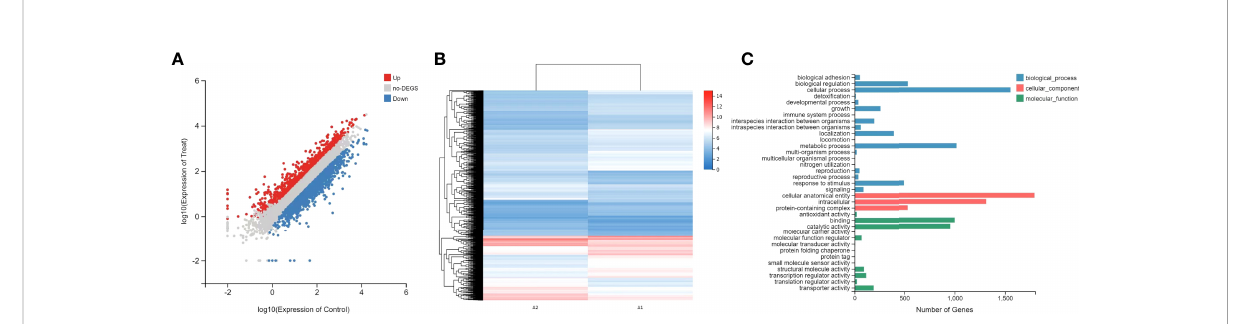
FIGURE 5 (A) Scatter plot of RNA-seq expression analysis. Upregulated genes are marked in red, and downregulated genes are marked in blue. (B) Heat map of RNA-seq expression analysis. Genes with statically signi fi cant changes were utilized to construct the heat map. The red color indicates relatively high expression, and the blue color indicates relatively low expression. (C) GO functional analysis of DEGs based on the RNA-seq data. GO functions are divided into three main categories: biological process (blue), cellular component (red), and molecular function (green). The x- axis represents the number of genes that have the GO function.